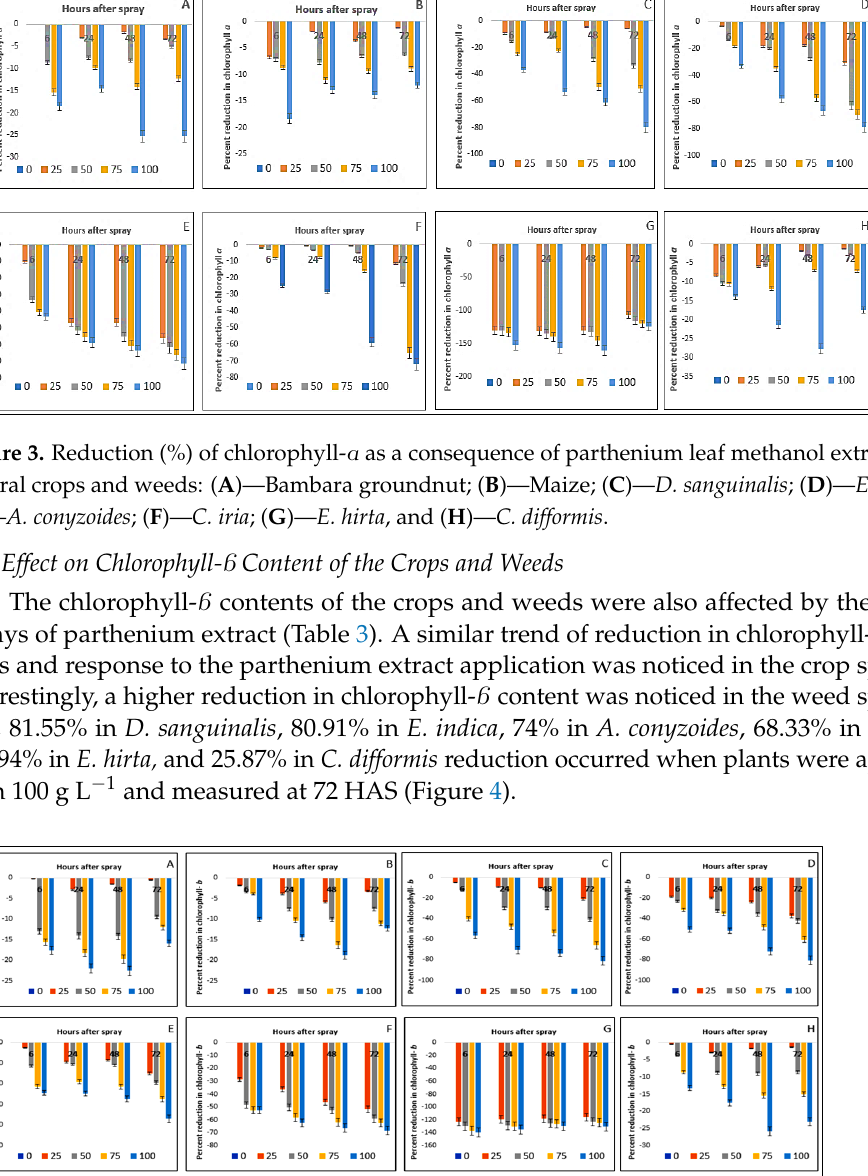
Figure 4. Reduction (%) of chlorophyll- b as a consequence of parthenium leaf methanol extract on several crops and weeds: ( A ) -Bambara groundnut; ( B ) -Maize; ( C ) - D. sanguinalis ; ( D ) - E. indica ; ( E ) - A. conyzoides ; ( F ) - C. iria ; ( G ) - E. hirta , and ( H ) - C. difformis .